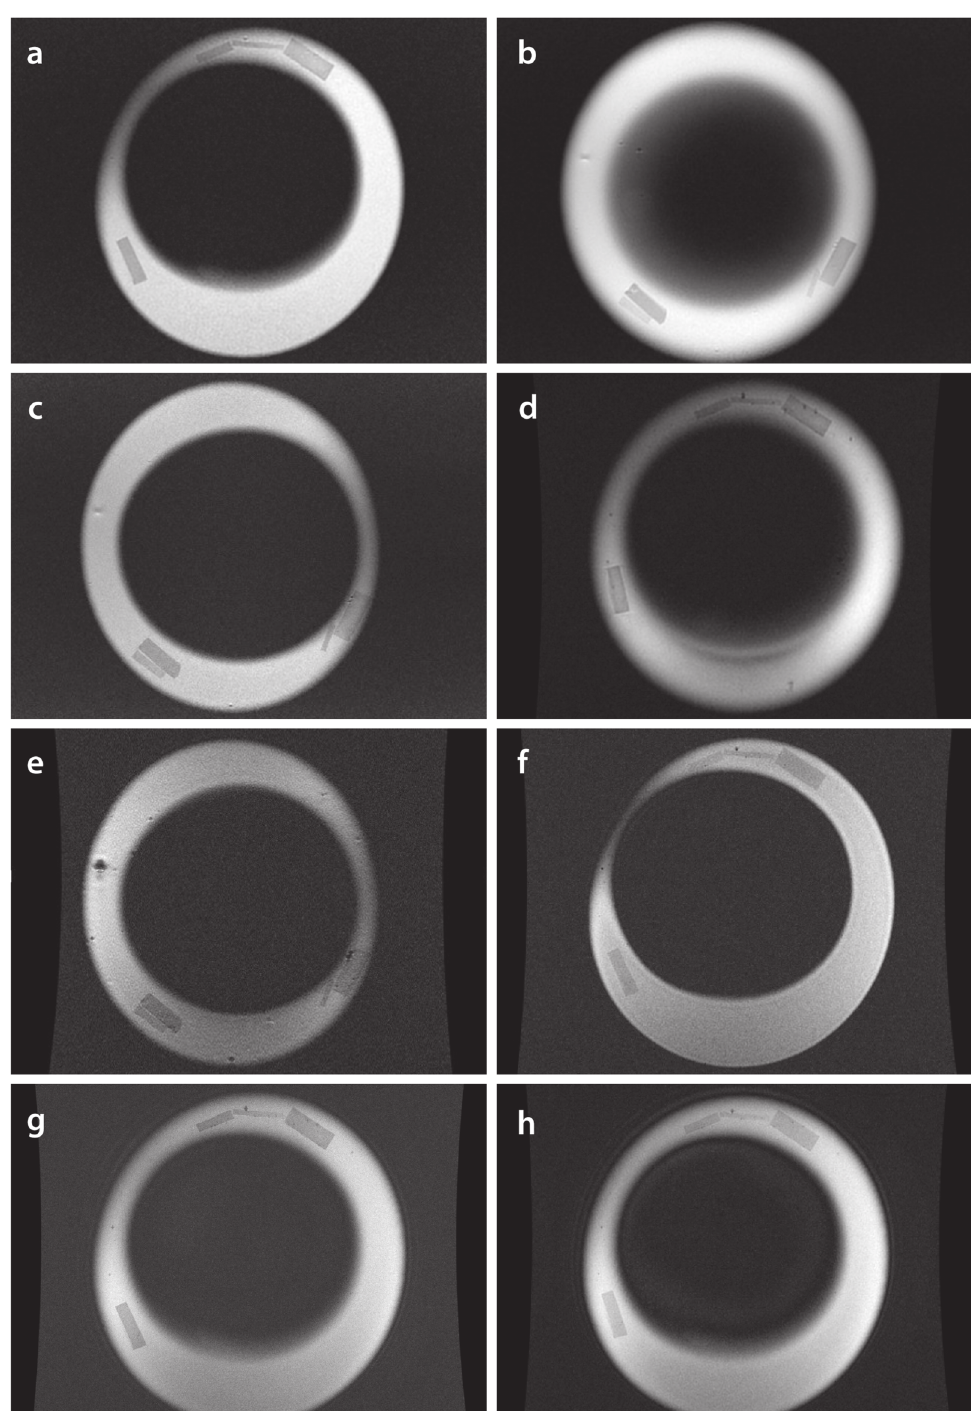
Figure 2 - Coronal MR images generated by various sequences and parameters. (a) T1-weighted spin-echo (SE), 320 x 320 pixels, 1.5-mm slice thickness; (b) T1 SE, 320 x 320 pixels, 4-mm slice thickness; (c) T1 SE, 512 x 512 pixels, 1.5-mm slice thickness; (d) Multiplanar gradient-recalled echo (GRE MPGR), 320 x 320 pixels, 1.5-mm slice thickness; (e) GRE MPGR, 512 x 512 pixels, 1.5-mm slice thickness; (f) Fast spoiled gradient-recalled echo (FSPGR), 512 x 512 pixels, 0.5-mm slice thickness; (g) FSPGR, 1024 x 1024 pixels, 1.5-mm slice thickness; (h) FSPGR, 512 x 512 pixels, 1.5-mm slice thickness.